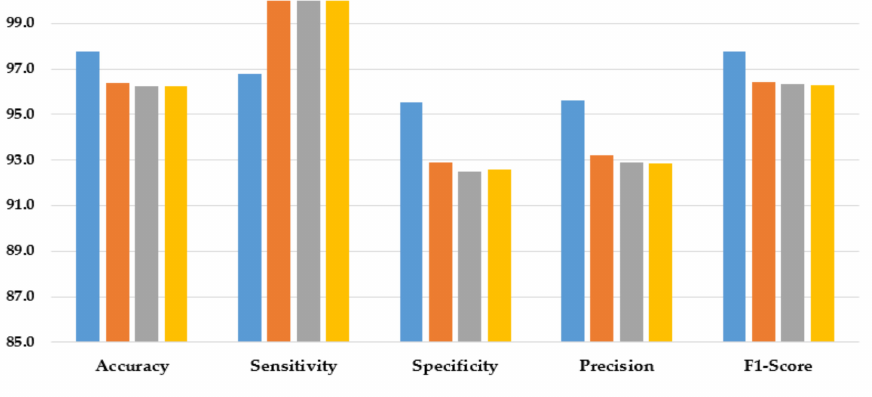
Figure 6. Comparison of the proposed method using four feature selection methods to diag- nose